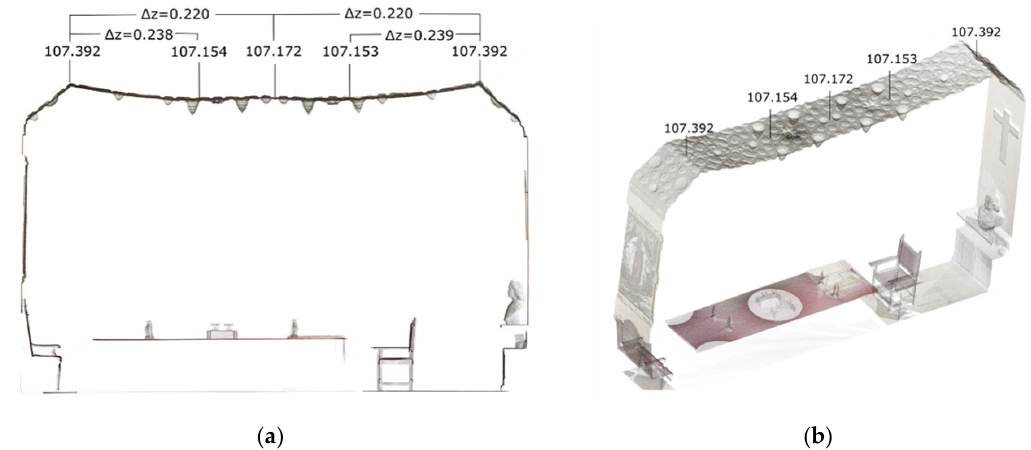
Figure 18. Longitudinal cross-section through the room centre including measurement of deformations: ( a ) Section BB'. ( b ) Section-perspective view.